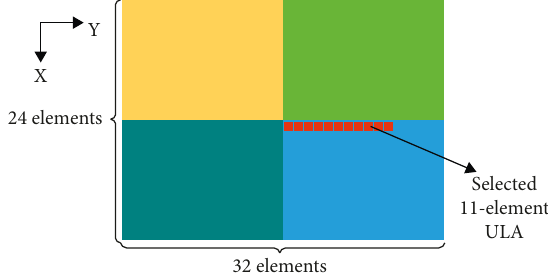
Figure 13: Specially selected 11 elements for experiment.